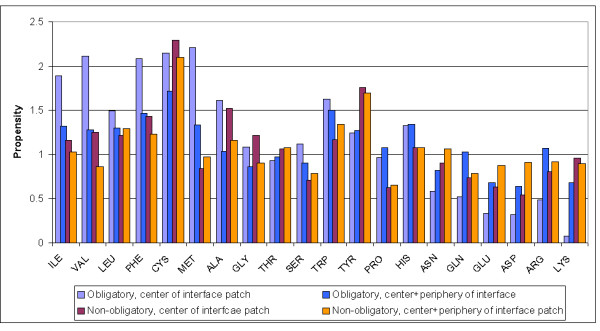
Plot showing the residue propensity in obligatory and non-obligatory interfaces. Propensities of the residues in the entire interface as well as at the core of the interface are shown.